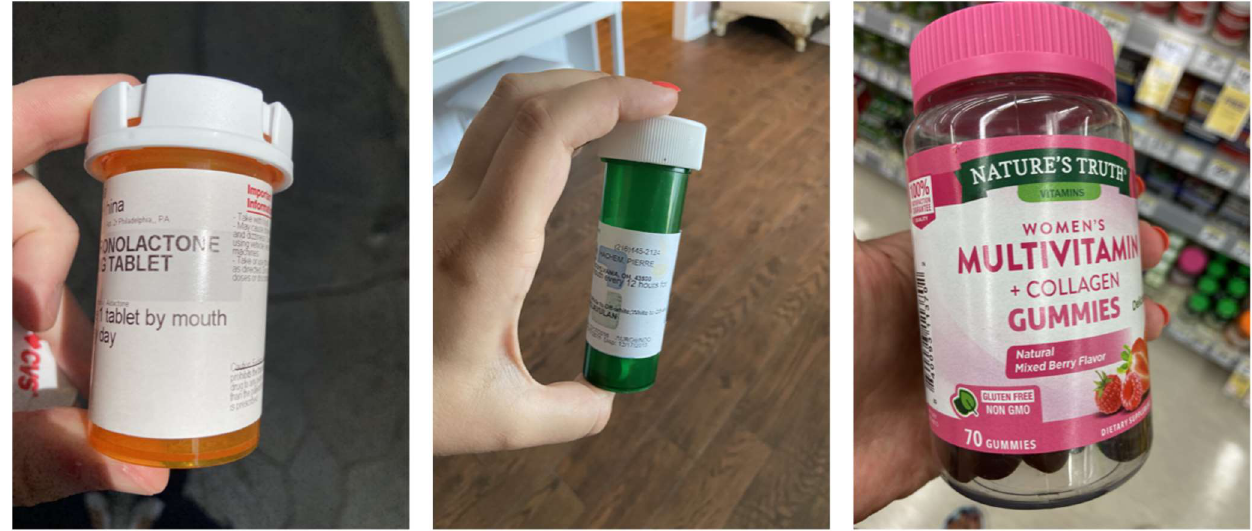
Figure 5. Sample images used to train